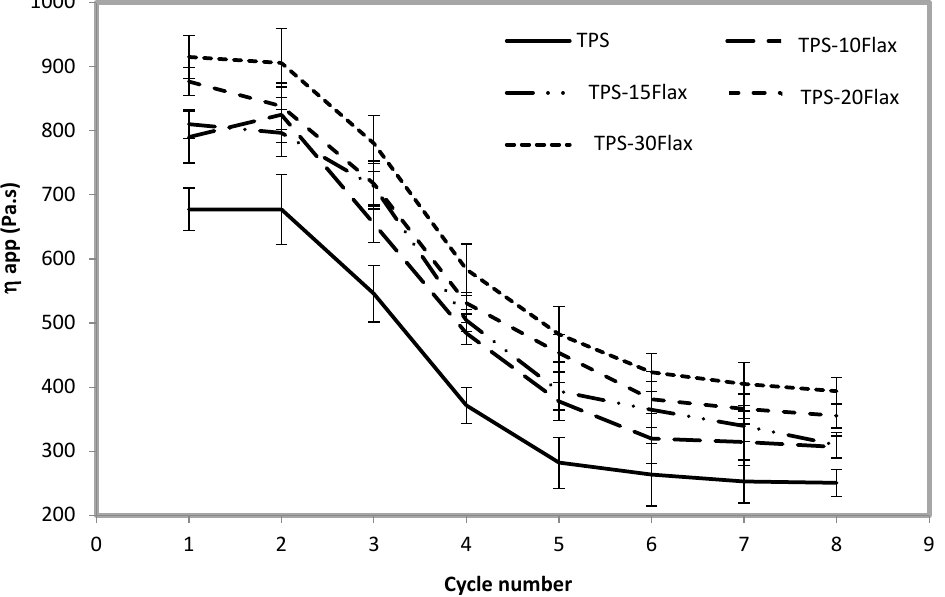
Figure 6. Variation in the apparent viscosity of the TPS mixtures (% percentage) flax shives as a function of the number of cycles (temperature 145 °C).